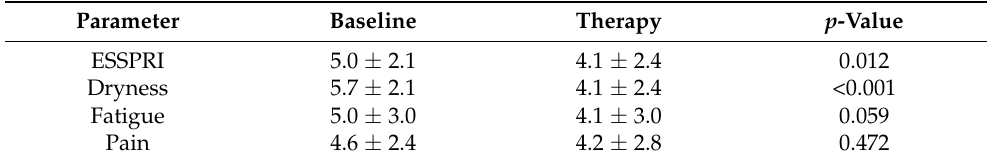
Figure 1. Effect of the liposomal inhalative therapy on the single items of the ESSPRI at baseline and after therapy. The significant improvement of the ESSPRI was mainly based on the improvement of general reported dryness. Table 3. Improvement of the ESSPRI (EULAR SS patient reported index) during the course of the treatment.